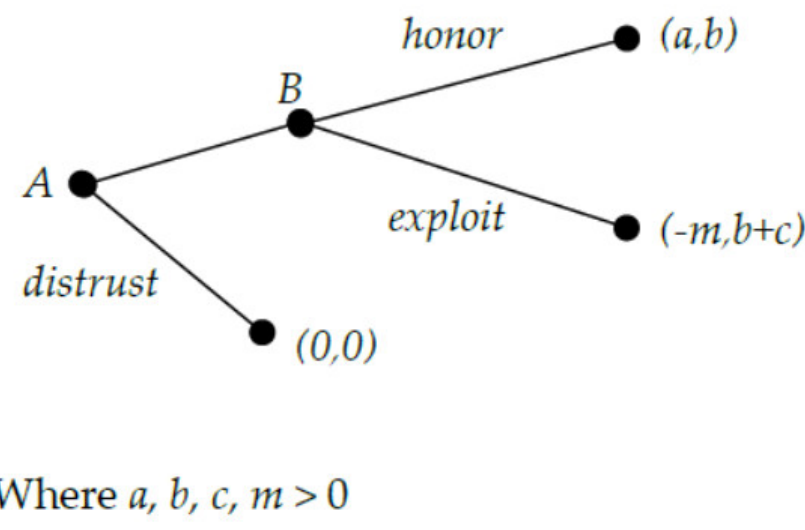
Figure 2. The Property-right Game .